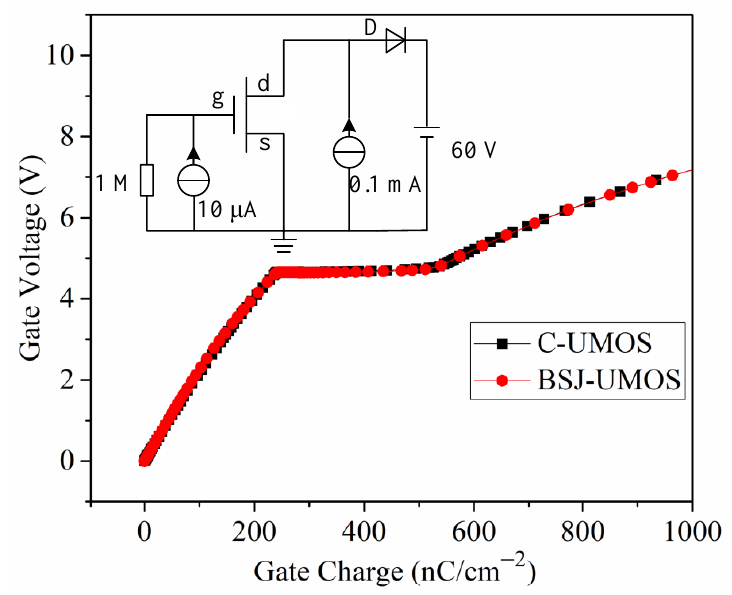
Figure 11. Comparisons of the gate charge performances.